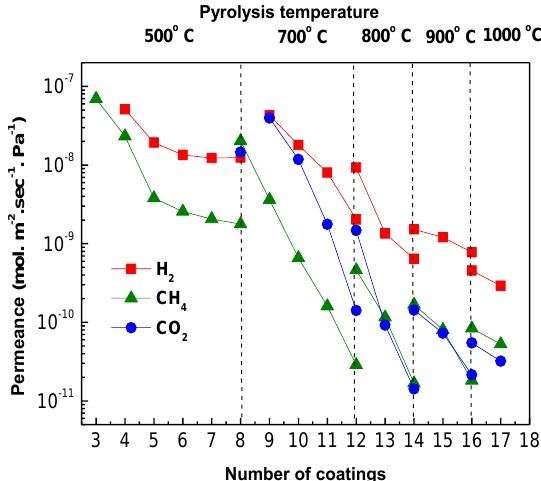
Figure 9. Permeance of H 2 , CH 4 and CO 2 as a function of number of coatings after pyrolysis at 500 °C, 700 °C, 800 °C, 900 °C or 1000 °C for the C1-TS membrane.